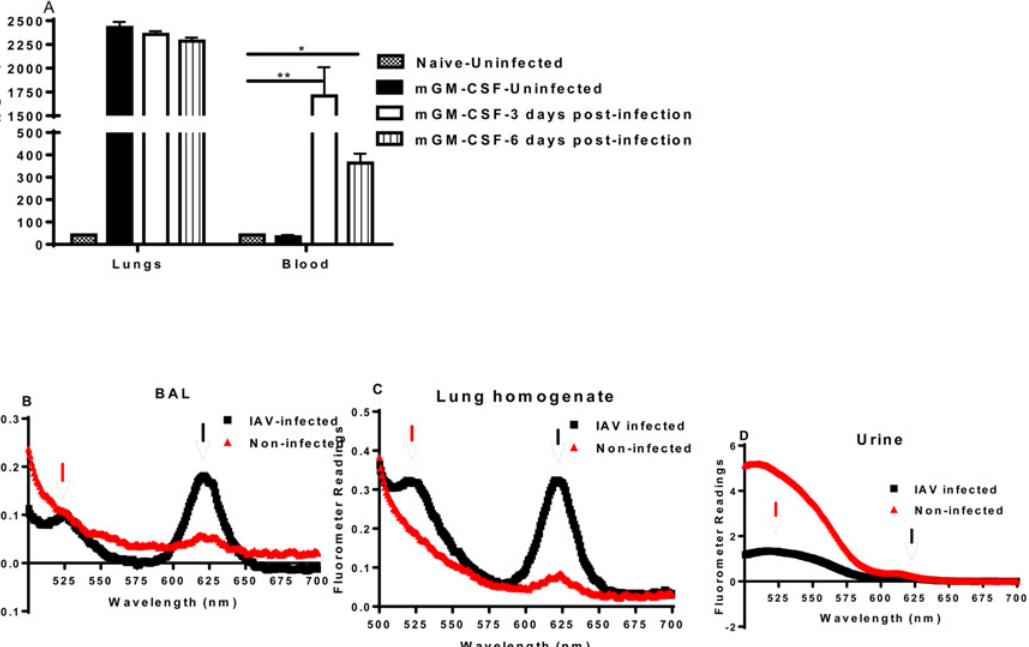
Fig 4. Lung injury in IAV-infected lungs facilitates movements of molecules from and to the alveolar space. A) Groups of wild type C57BL/6 mice were infected with 1.0 LD50 of PR8 and then treated intranasally with 12.5 μ g of GM-CSF on days 0, 3, and 6 after IAV infection. Levels of GM-CSF are shown 3 hours after treatment. * p < 0.001, ** p < 0.0001. n = 5. B-D) The abundance of Q-Dots in BAL, lungs and urine . Wild type C57Bl/6 mice were infected as in panel A and 7 days after infection, mixture of two different Qdots (13nm and 20nm) were given intravenously. Passage of different particle size through the lung vasculature and glomerular capillary filtration of na ï ve and IAV-infected mice are depicted. Representative of three independent experiments with similar results are shown from 3 – 5 mice/group. Samples from na ï ve mice were used as controls and showed no fluorescence. Red and black arrow indicates 13nm and 20 nm Qdots,